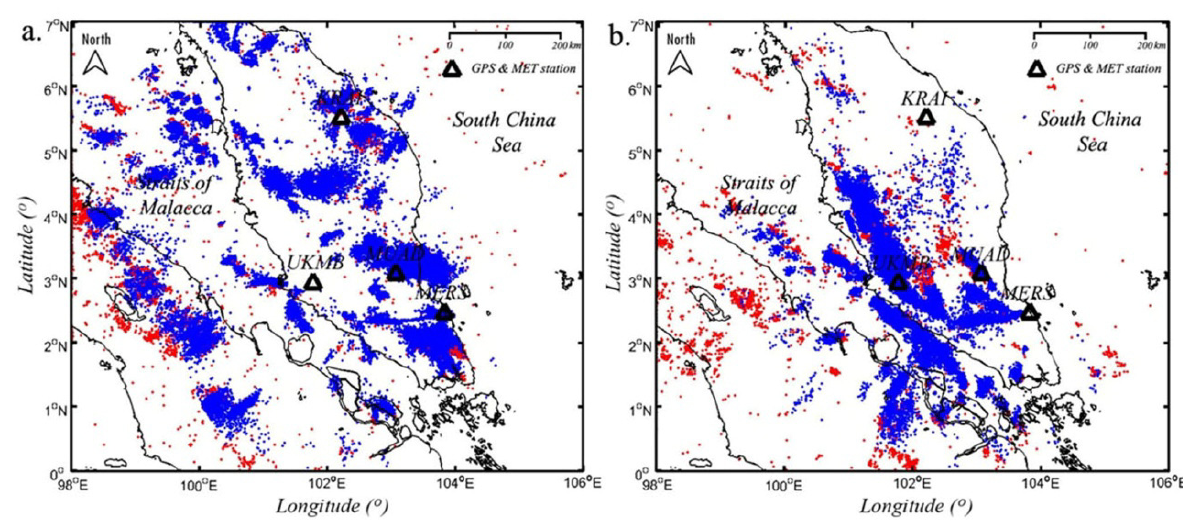
Figure 4. Examples of the heavy lightning days over the Peninsular Malaysia during (a) May 1st, 2009, and (b) November 7, 2009.